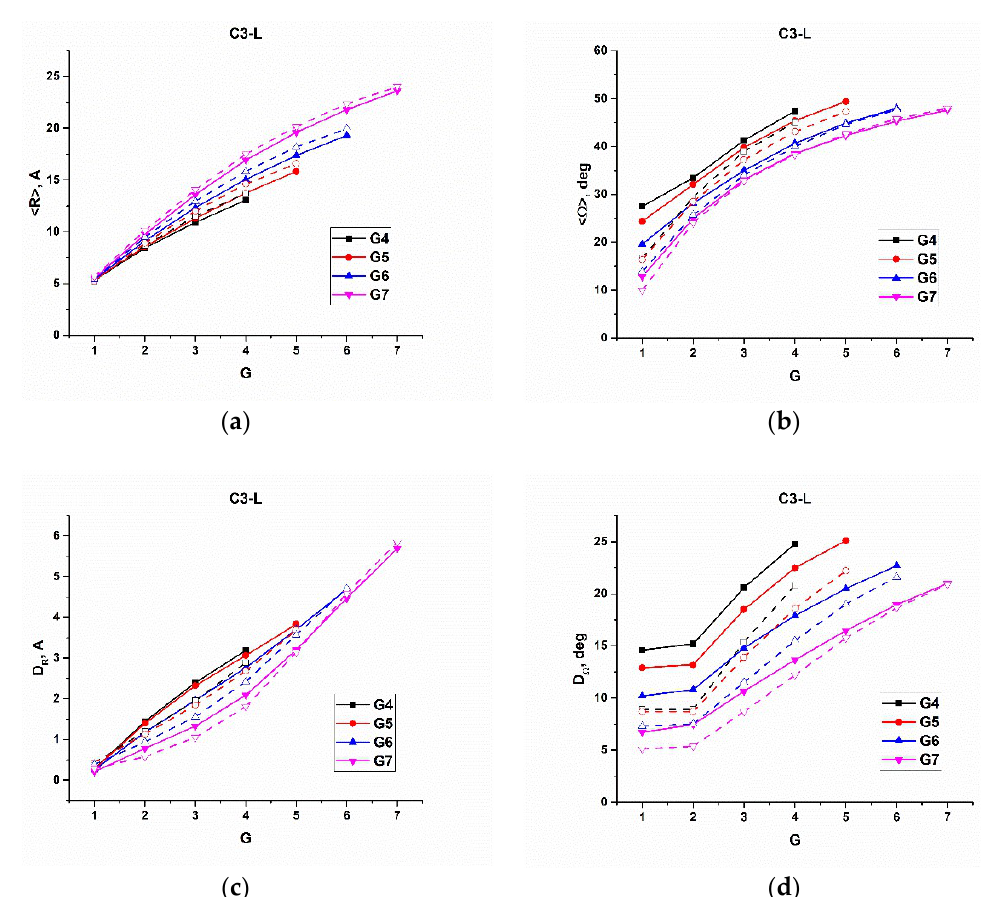
Figure 6. ( a ) The average distance, <R>, of the Si branching atoms to the core atom, ( b ) the average angle, <Ω>, between the Si atom and the center of mass of the dendron ( c ) the square root of the R dispersion, D R , and ( d ) the square root of the Ω dispersion, D Ω , calculated for c3-dendrimers (solid lines) and for l-dendrimers (dashed lines).